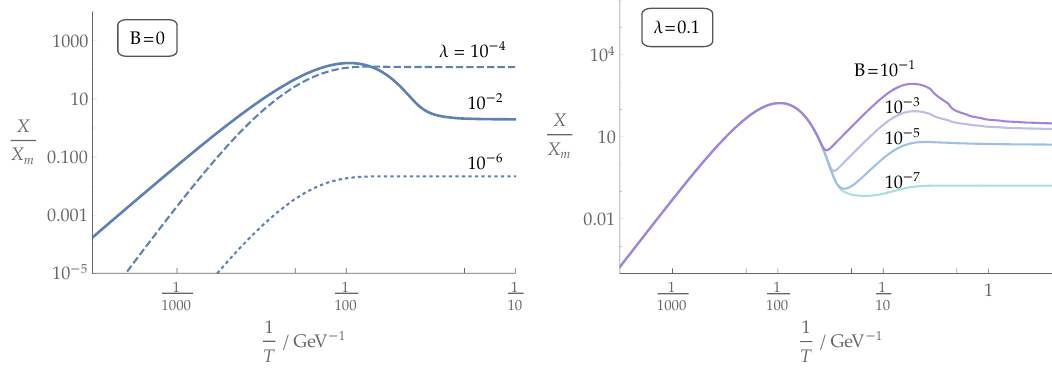
Figure 2 . Left: the evolution of the comoving DM number density X (de(cid:12)ned in eq. (4.2), normalised to the value required to match the observed DM relic abundance X m ) as a function of the visible sector temperature T , in non-thermal Higgs portal DM models with di(cid:11)erent values of the portal coupling (cid:21) . The reheating temperature is (cid:12)xed to 10 GeV, the DM mass is set at 600 GeV, and the modulus branching fraction to DM is B = 0, so that DM is only produced from the visible sector thermal bath. Right: the evolution of X in models with di(cid:11)erent values of the modulus branching ratio to DM. The reheating temperature is (cid:12)xed to 10 GeV, the DM mass is 600 GeV, and the portal coupling is (cid:21) = 0 : 1. At early times DM is produced from the thermal bath, and then freezes out during matter domination. Subsequently, the majority of DM is produced from modulus decays, when the visible sector temperature is around the reheating